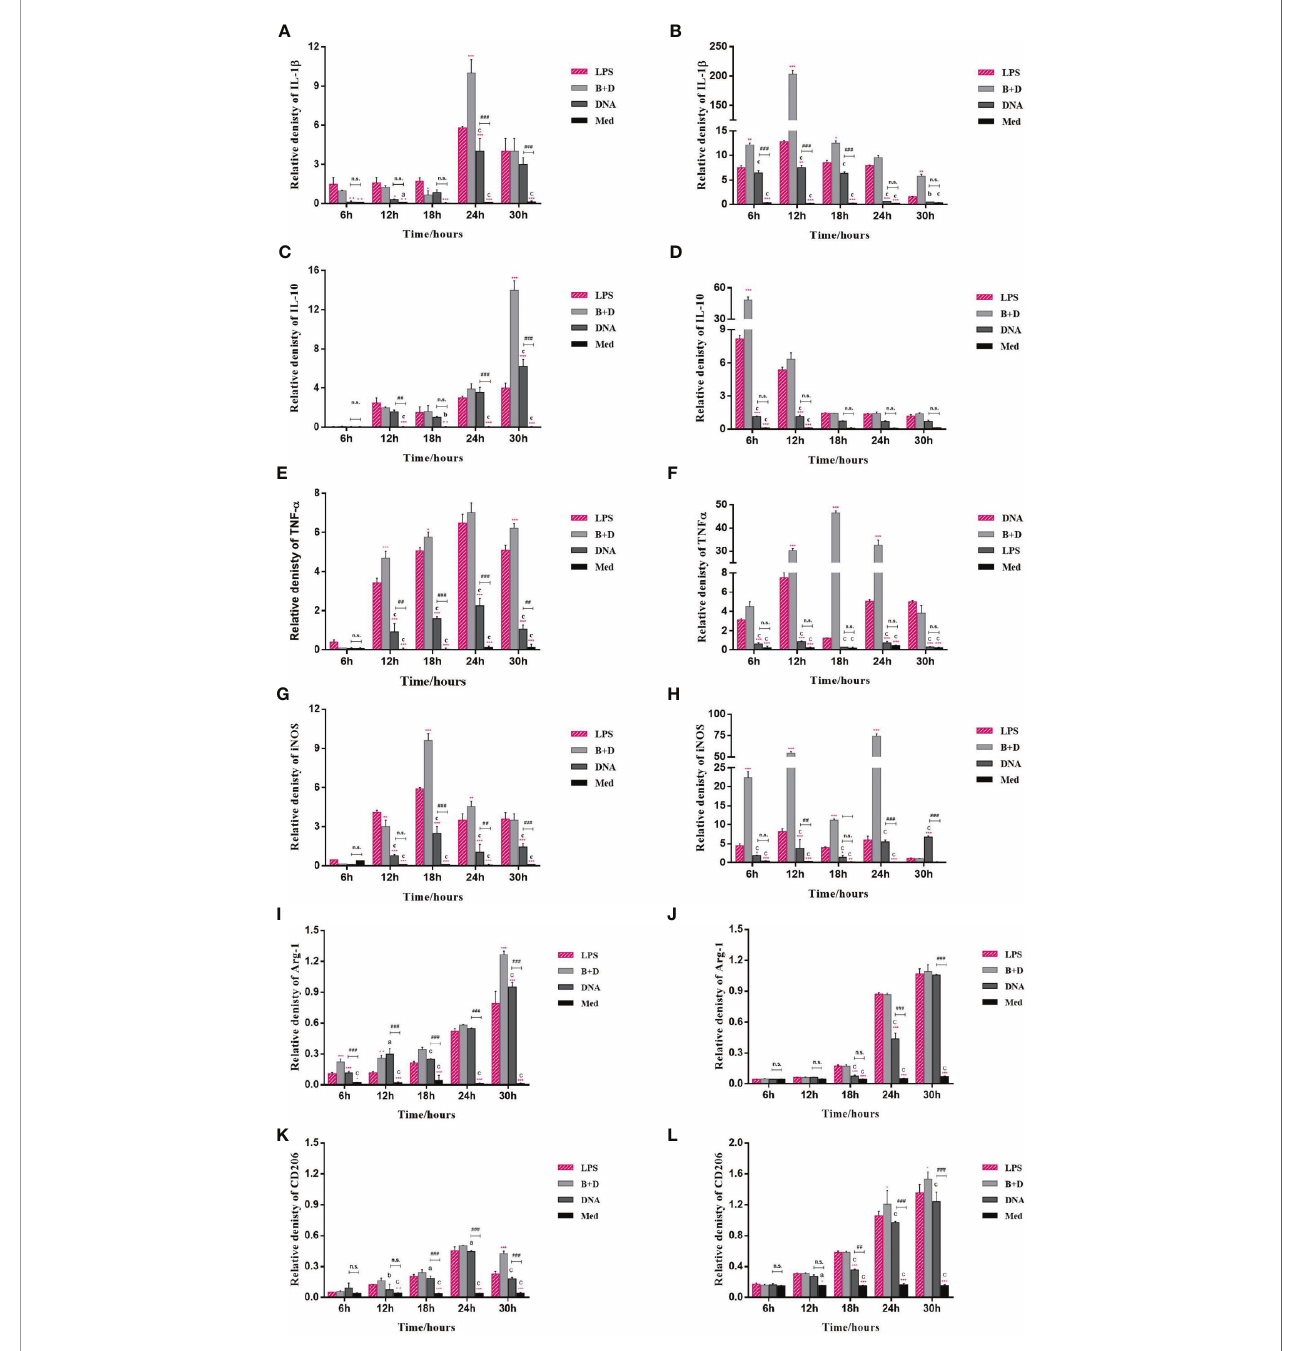
FIGURE 3 | mRNA expression of in fl ammatory factors in RAW264.7 cells and peritoneal macrophages. RAW264.7 cells and peritoneal macrophages were incubated with plasmid pCI – PoRV – VP6 (1 mg/mL) and bacterial ghosts (BGs) loaded with pCI – PoRV – VP6 (1000 bacteria/cell), respectively. Total RNA was extracted at different times, and the mRNA expression of in fl ammatory factors was quanti fi ed using RT – qPCR. mRNA expression of (A) IL – 1 b in RAW264.7 cells, (B) IL – 1 b in peritoneal macrophages, (C) IL – 10 in RAW264.7 cells, (D) IL – 10 in peritoneal macrophages, (E) TNF – a in RAW264.7 cells, (F) TNF – a in peritoneal macrophages, (G) iNOS in RAW264.7 cells, (H) iNOS in peritoneal macrophages, (I) Arg – 1 in RAW264.7 cells, (J) Arg – 1 in peritoneal macrophages, (K) CD206 in RAW264.7 cells, and (L) CD206 in peritoneal macrophages. Values are expressed as the mean ± SD of four individual experiments. Signi fi cance of differences between the LPS, BG +DNA, DNA, and Macrophage culture medium (Med) groups is represented as follows: *P < 0.05, **P < 0.01, ***P < 0.001. Letter indicates a signi fi cant differences between BG+DNA, DNA, and Med groups: a P < 0.05, b P < 0.01, c P < 0.001. #Asterisk indicates signi fi cant difference between DNA groups and Med groups: # P < 0.05, ## P < 0.01, ### P < 0.001. n.s., no signi fi